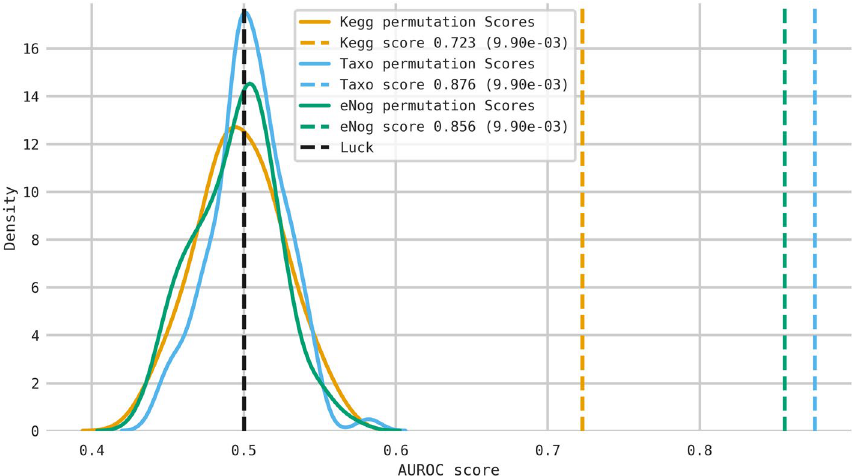
Figure 5. Significance of the cross-validated score through the use of the target permutation technique for each metagenomic profile (KEGG, eggNog and taxonomic). The p-value approximates the probability that the score for each profile would be the result of chance. The number of permutations is 100 for each profile using the consensus signature previously learnt and a 100-times tenfold cross-validation schema. Note that the worst outcome is 1 and the best is ~ 0.009. The vertical lines for each profile report the true score without permuting the outcome (being CRC or healthy) and the luck threshold (in black), whereas the continuous color lines show the permutation scores distribution (i.e. the null distribution) for each profile.